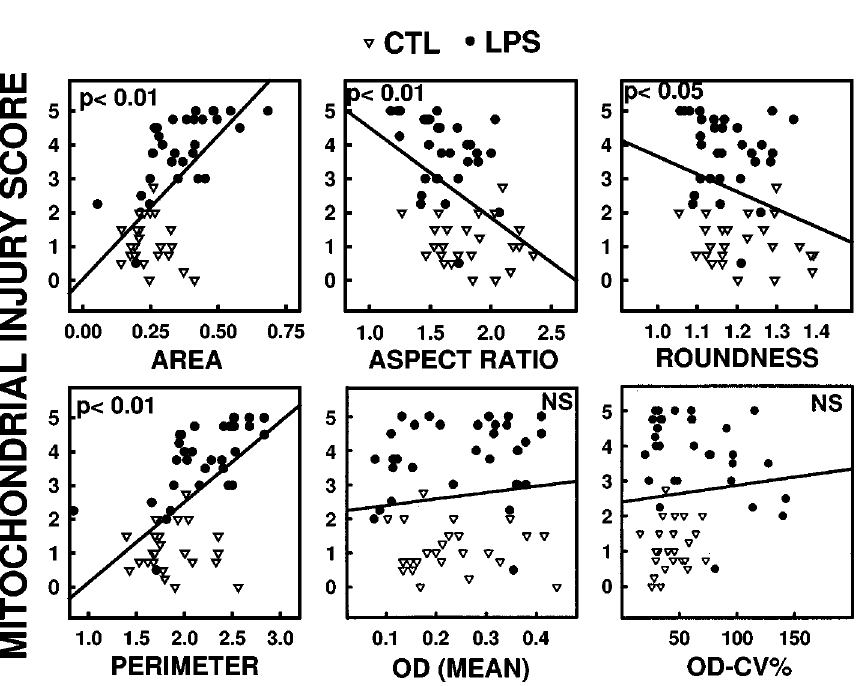
Fig. 4. Relationship between the mitochondrial injury score and the digital imaging parameters assessed 4 hours after the treatment with LPS (black circles) and in time-matched Controls (open triangles). Evaluations of mitochondrial ultrastructure using the qualitative scoring method (i.e., mitochondrial injury scores) were highly correlated with respect to changes in area, aspect ratio, roundness and perimeter, but not with the OD